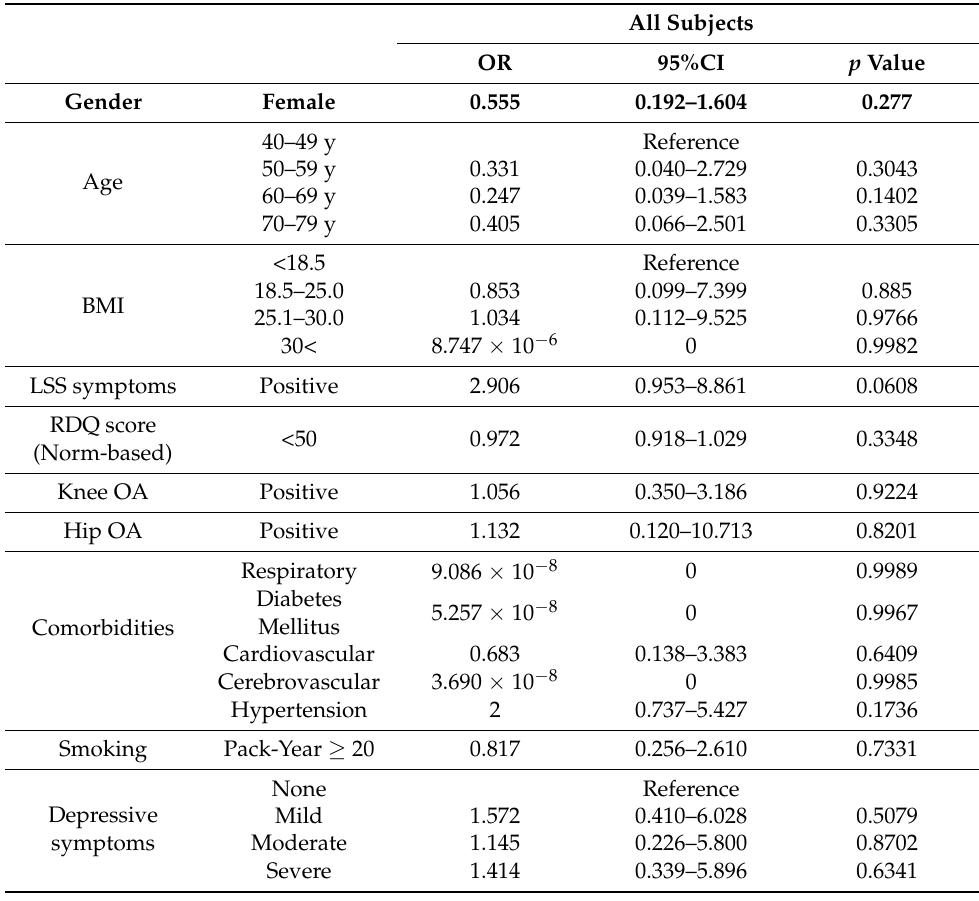
Table 8. Predictive factors of the operation for LSS during the six-year follow-up